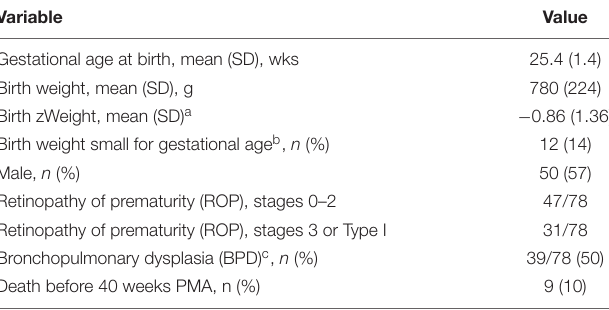
TABLE 1 | Demographic data of the study population ( n =